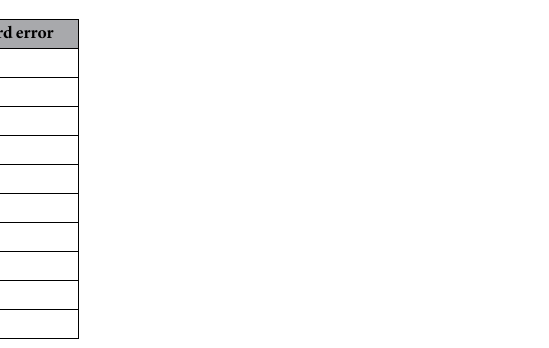
(Fig. 3a). With increasing species richness the degree of species segregation changed towards random (Fig. 3a). In contrast, Akaike model comparison indicated that the degree of nestedness was highest at intermediate species richness (Fig. 3b, r 2 = 0.21, AICc = 84.3) in comparison with a linear increase (r 2 = 0.07, AICc = 96.1). The degree of spatial species segregation increased with increasing soil Ca (Fig. 4b) and Mg (Fig. 4c) con- tent, as well as with increasing pH (Fig. 4e), nutrient (Fig. 4f), and moisture (Fig. 4g) demands. Species segre- gation decreased with increasing C/N ratio (Fig. 4h). In turn the degree of nestedness increased with stand age (Fig. 4a), pH (Fig. 4e) and nutrient (Fig. 4f) and moisture demands (Fig. 4g). The level of nestedness decreased with increasing soil nitrogen content (Fig. 4d). After accounting for the co-variance with species richness and spatial autocorrelation (Table 2), the degree of species spatial segregation was still significantly influenced by soil nitrogen content and moisture demands, and to a lesser degree by pH (Table 2). In turn, the degree of nestedness increased with productivity (Table 2), although this increase was not significant at the 5% error level (Table 2) and explained at most 8% of variance in the standardized effect size of NODF. The degree of nestedness increased with increasing species richness (OLS r 2 = 0.28). We did not find an indication for the highest NODF at intermediate richness (quadratic OLS r 2 = 0.30, quadratic term not significant at p < 0.05, ( Δ AICc < 1). Compositional similarity as quantified by the Soerensen metric decreased with increasing soil productivity (Supplement Fig. S2a). As in the case of nestedness this pattern was largely due to the covariance with spe- cies richness (Table 2). After accounting for richness effects and spatial autocorrelation compositional similar- ity was not significantly influenced by soil variables except for a weak effect of nitrogen content. Variability in